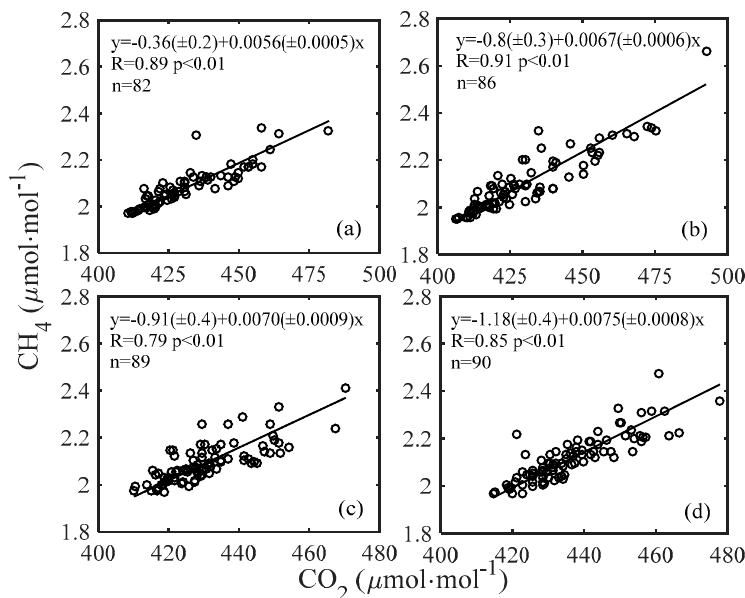
Figure 9. Same as Figure 8 except for winter (December–February) nighttime: ( a ) December